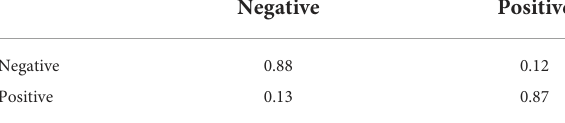
TABLE 9 2-Class sentiment classification confusion matrix (Flat-OCC +